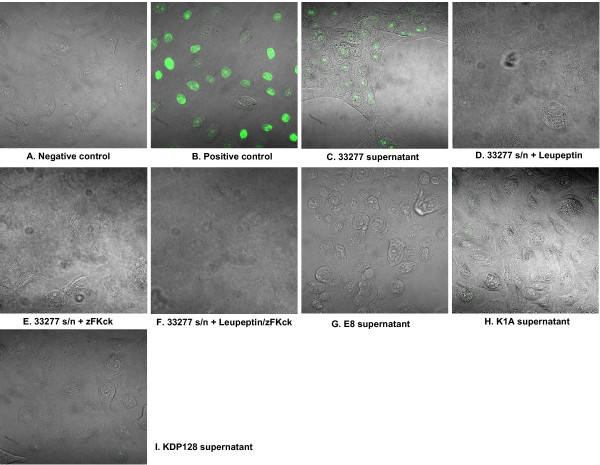
TUNEL assay to detect DNA fragmentation by confocal microscopy. Images are fluorescent confocal staining at ×600 magnification. Negative control was unchallenged HGECs at 24 h (A). Positive control was HGECs treated with DNase 1000 U/ml (B). HGECs were challenged with filtered supernatant of P. gingivalis 33277 culture (C) for 24 h. Additional plates (D to F) show challenge with live P. gingivalis 33277 supernatant pretreated with leupeptin, a selective Rgp inhibitor (D), zFKck, a selective Kgp inhibitor (E), or a cocktail of both inhibitors to inhibit total gingipain activity (F). Challenge for 24 hours with filtered culture supernatant derived from the RgpA/RgpB mutant E8 (G), the Kgp mutant K1A (H) or the RgpA/RgpB/Kgp mutant KDP128 (I), are also shown.